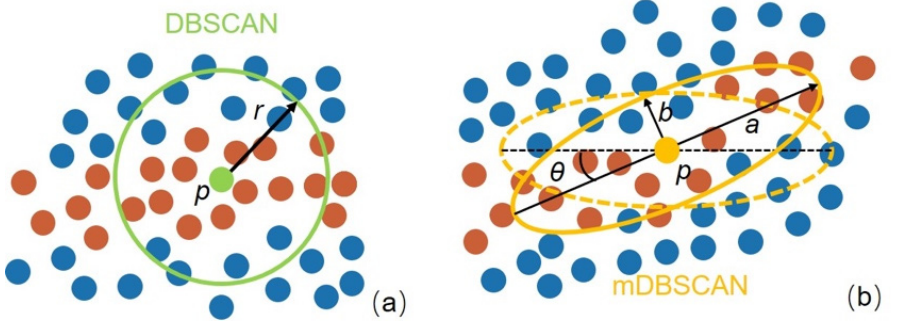
Figure 4. Circular and elliptical neighborhood of a given point p in the Density-Based Spatial Clustering of Applications with Noise (DBSCAN) method. Red points and blue points correspond to signal and noise photons, respectively. ( a ) Circular neighborhood with a radius of r . ( b ) Elliptical neighborhood with a major axis of a and a minor axis of b . In addition, the rotation angle θ is defined as the angle between the major axis and the horizontal line in anticlockwise direction.